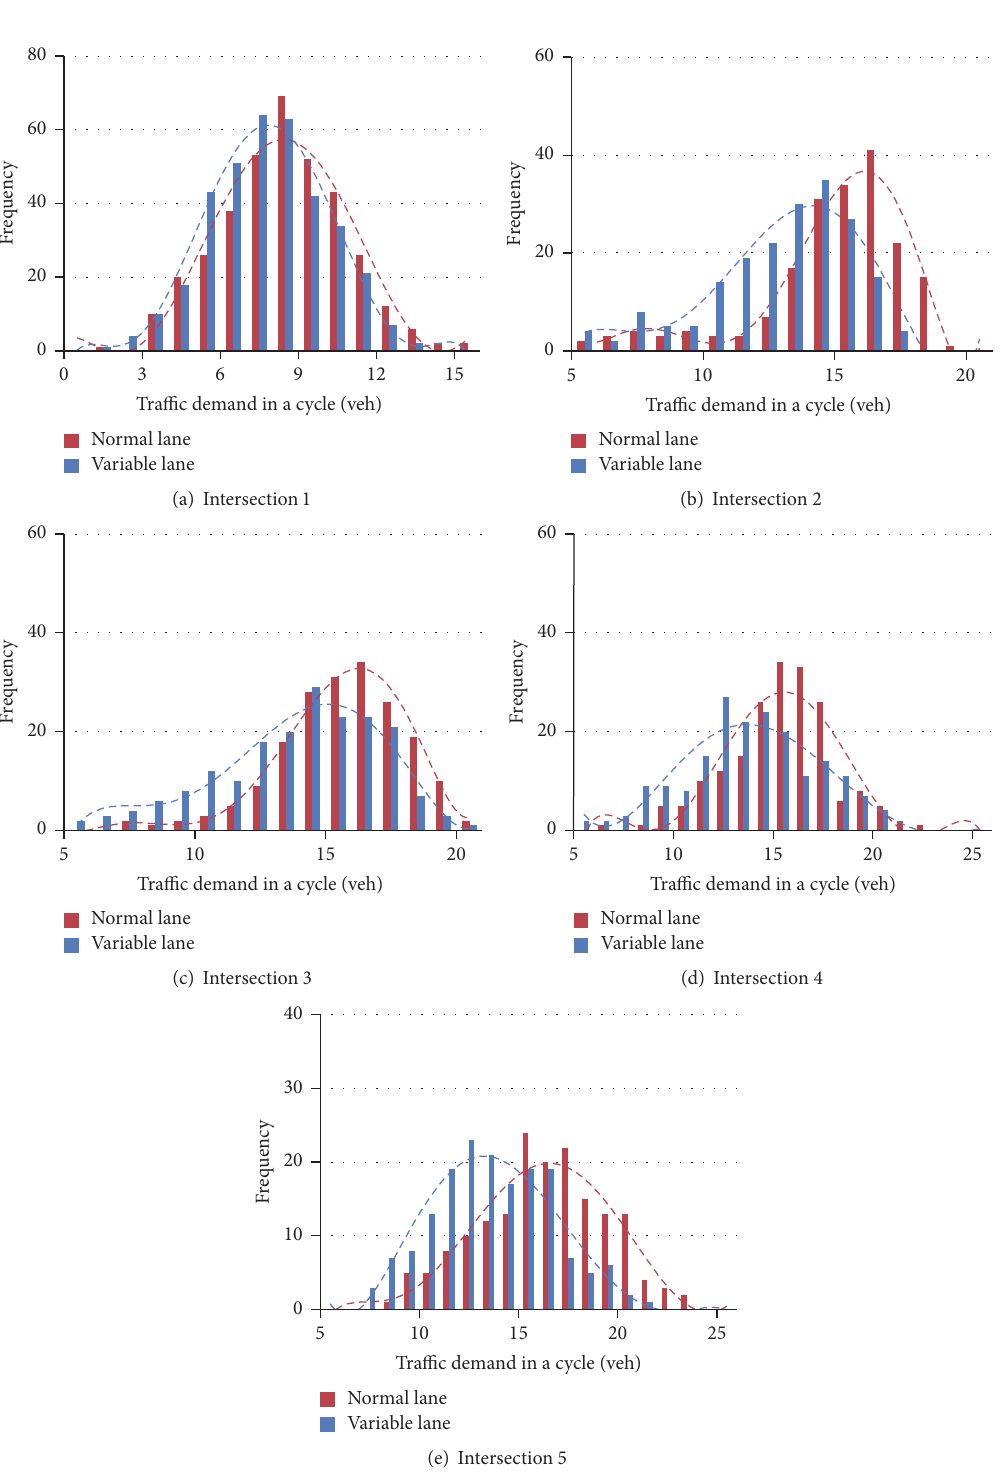
Figure 5: Distribution of traffic